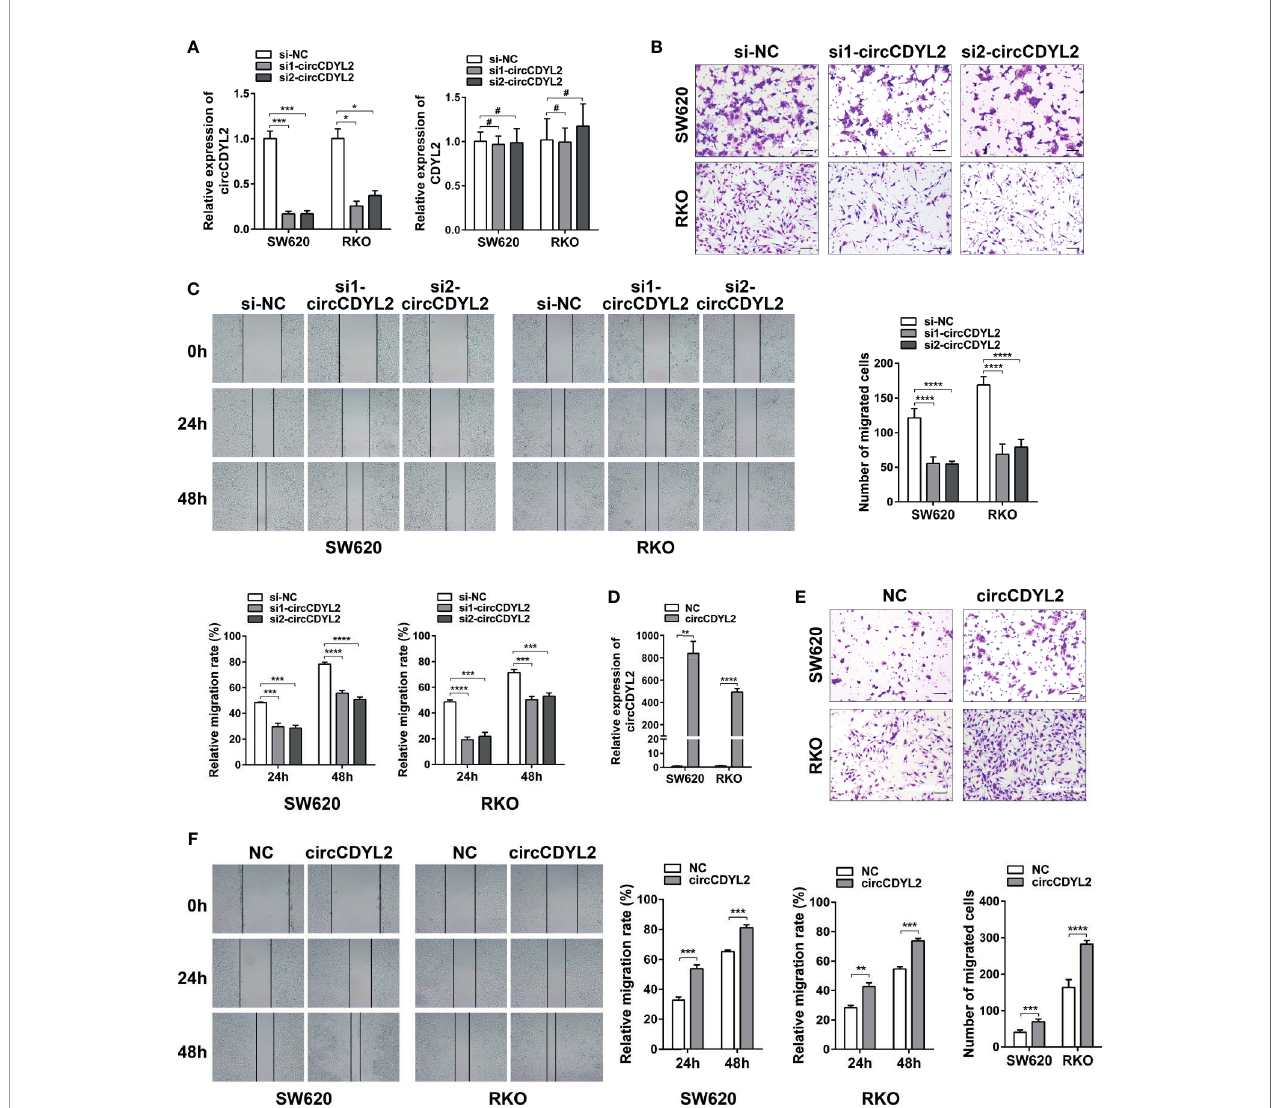
FIGURE 4 | CircCDYL2 promoted CRC cell migration in vitro . (A) The relative expression levels of circCDYL2 and CDYL2 in SW620 and RKO after transfection with siRNAs targeting the circCDYL2 splicing junction. (B) Transwell migration assay demonstrated that decreased circCDYL2 levels suppressed CRC cell migration. Scale bars: 50 m m. (C) Wound healing assay indicated that silencing circCDYL2 inhibited CRC cell migration. (D) CircCDYL2 was overexpressed after transfection with circCDYL2 expression vector. (E) Transwell migration assay showed that ectopic circCDYL2 increased cell migration. Scale bars: 50 m m. (F) Wound healing assay indicated that overexpression of circCDYL2 enhanced CRC cell migration. * p < 0.05, ** p < 0.01, *** p < 0.001, **** p < 0.0001, # p >